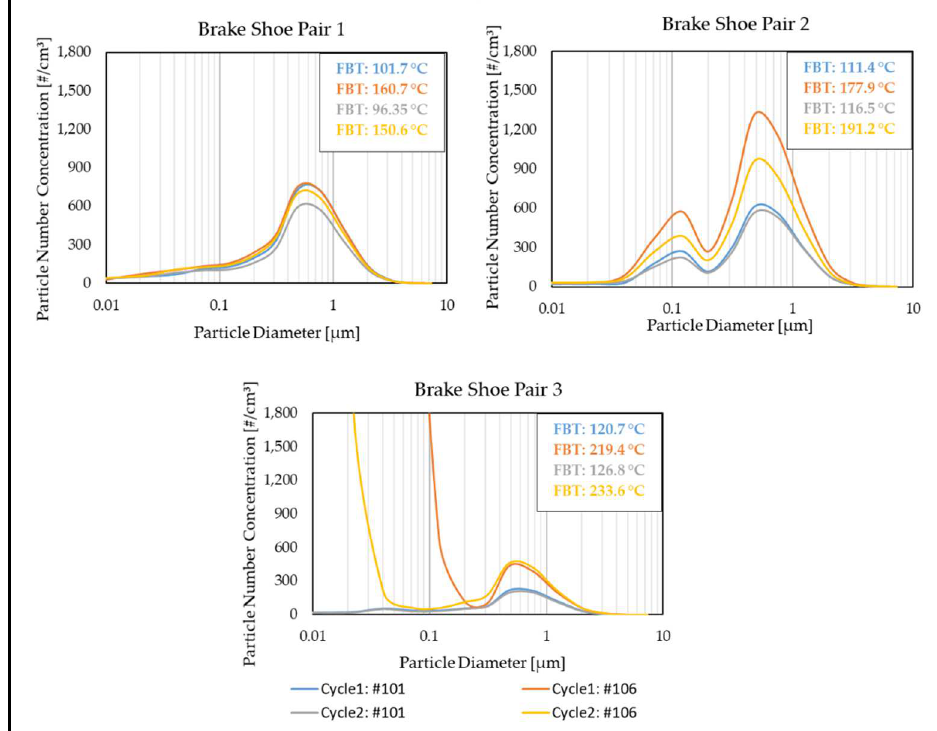
Figure 10. Particle size distribution (TPN measured with ELPI) during high-speed braking #101 and #106 in two consecutive WLTP Brake Cycle Trip 10. During the emission measurements of the brake drums, it was also noticed that the secondary particle emissions increase with each continuing WLTP Brake Cycle iteration until they stagnate at a constant level. The progression over the bedding and main emis- sions test is shown in Figure 11.